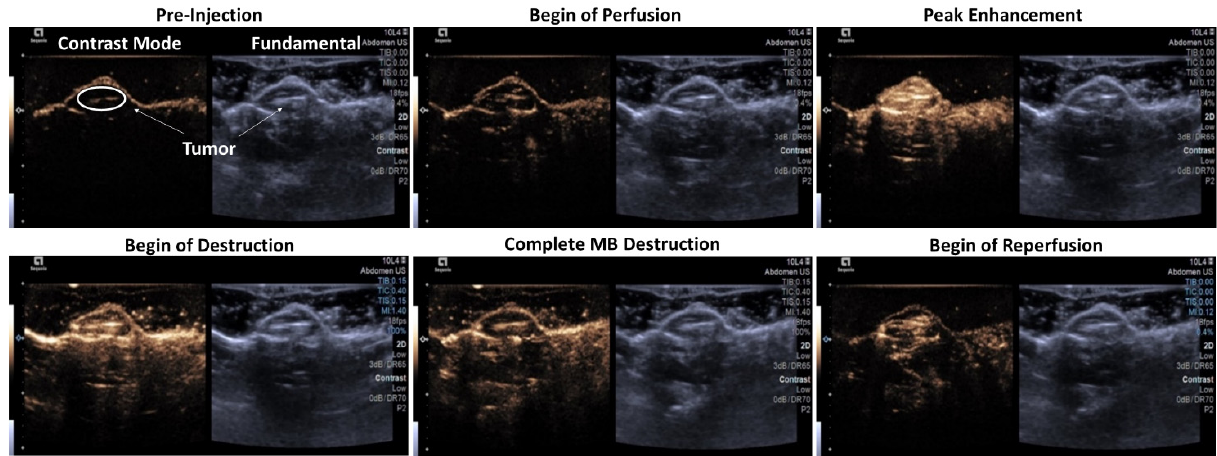
Figure 3. Illustrative ultrasound images of SE61O 2 /LND in an HNSCC tumor model generated in immunocompromised mice in dual B-mode/cadence pulse sequencing mode. Images show pre-injection of microbubbles (MB), start of MB perfusion, peak enhancement post-injection, start of MB destruction, complete MB destruction, and start of reperfusion (image depth corresponds to 0.3 cm increments). The left side of the display is the nonlinear imaging mode (contrast), and the right is the conventional B-mode (grayscale imaging).